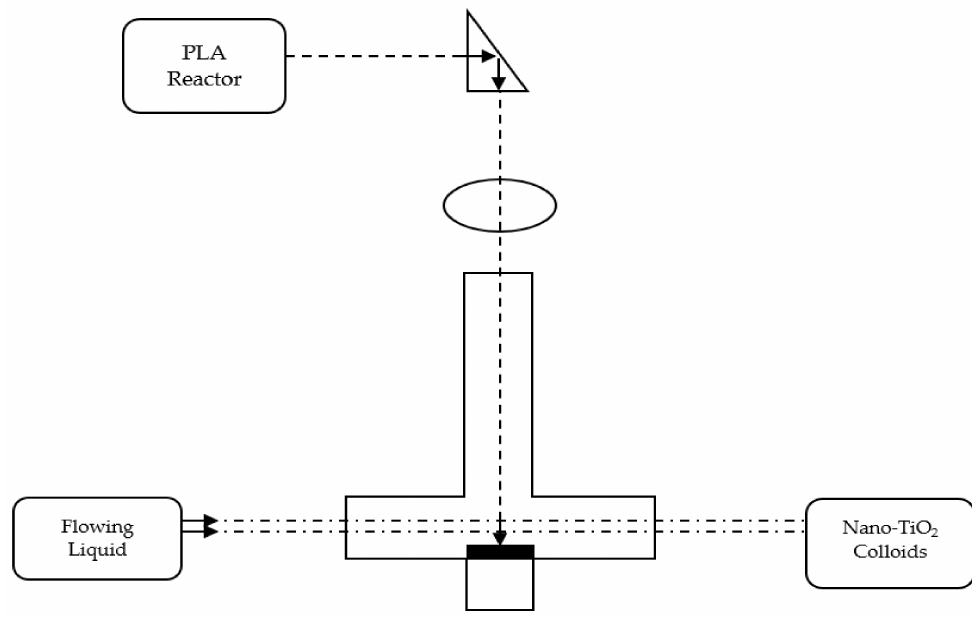
Figure 4. Pulsed laser ablation (PLA) model schematic diagram